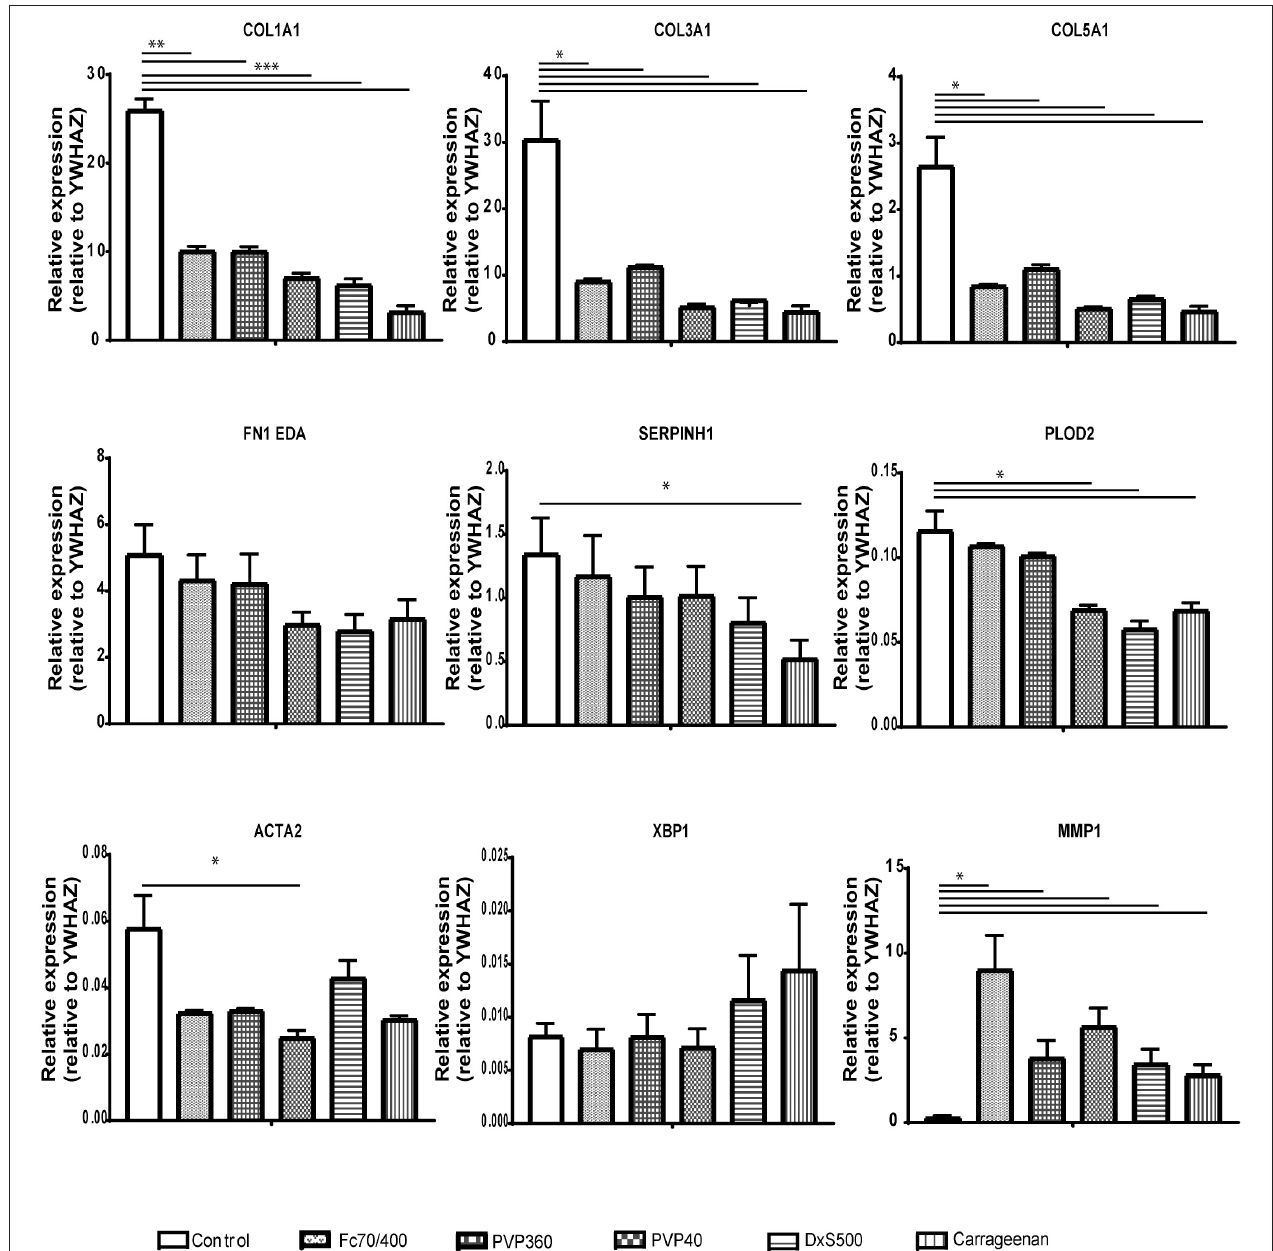
FIGURE 7 | Relative mRNA expression of fibrosis markers in dermal fibroblasts ( n = 4) after 96h of culture. mRNA expression of COL1A1, COL3A1, COL5A1, FN1EDA, SERPINH1, PLOD2, ACTA2, XBP1, and MMP1 in human dermal fibroblasts after 96h without stimulation with TGF β 1, cultured with macromolecular crowders Fc70/400 mixture, PVP360, PVP40, DxS500, and CR vs. control. * = P ≤ 0.05; ** = P ≤ 0.01; *** = P ≤